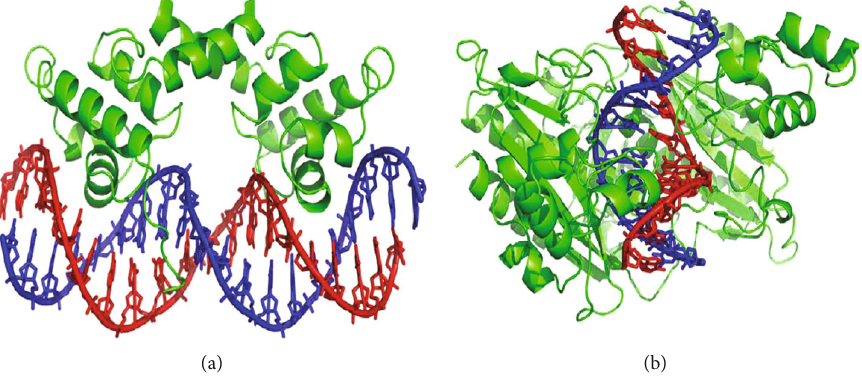
Figure 1: DNA binding protein bound to respective target DNAs. Created from PDB (a) 1LMB and (b) 1 RVA. Image source [6, 7],